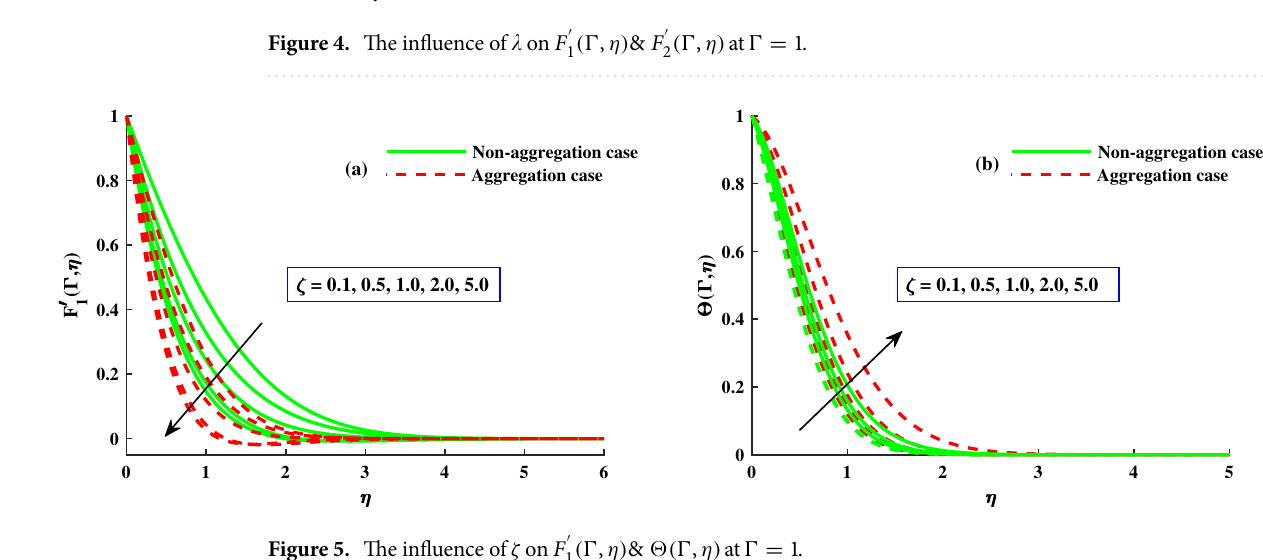
1 Figure 5. The influence of ζ on F ′ 1 (Ŵ , η) & �(Ŵ , η) at Ŵ = Re x 1 / 2 ) against upgrading values Re x 1 / 2 ) and ( C f Figure 6a,b depicts the distribution of friction factors ( C f y x of the parameters Ŵ (0:0.3:1.0) and M (1.0:1.0:5.0). Figure 6a demonstrates that for increasing Ŵ( 0 ) rightarrow 1 , Re x 1 / 2 ) increases steadily to a fixed rate and does not change noticeably; however, for strengthen M , a the ( C f x Re x 1 / 2 ) decreases steadily as significant decrease in the axial friction is observed. Figure 6b shows that the ( C f y 1 increases until it reaches a constant rate, at which point there is no discernible difference. However, Ŵ( 0 → when M is improved, the significance difference near the boundary surface is noted. Figure 7a,b shows that for 1 / 2 ) is gradually raised until it approach a constant rate, after which no significant 1 , the ( C increasing Ŵ( 0 f x Re x →